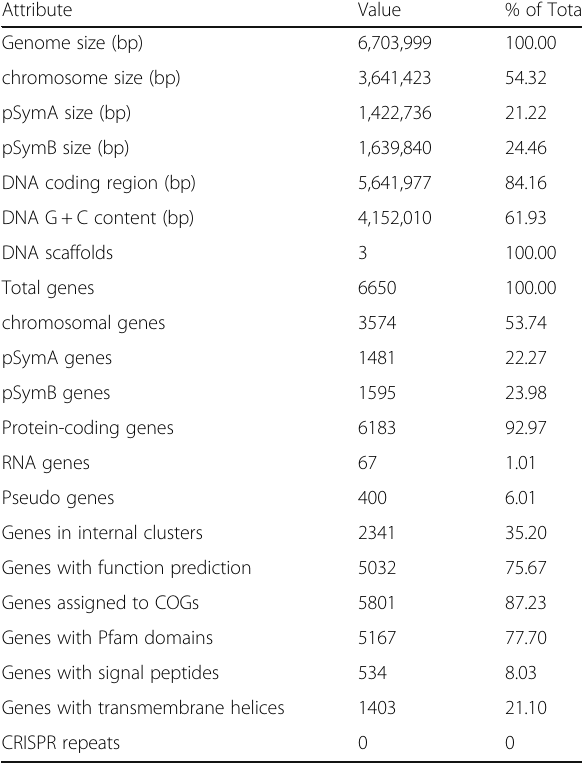
Table 4 Genome statistics for E. meliloti strain